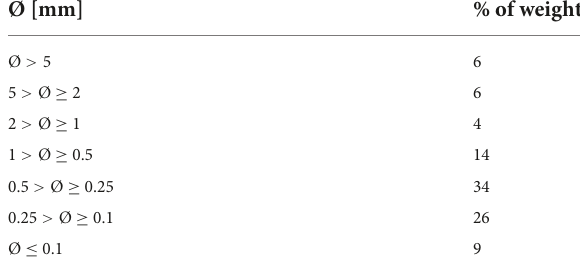
TABLE 2 Particle size distribution of analyzed